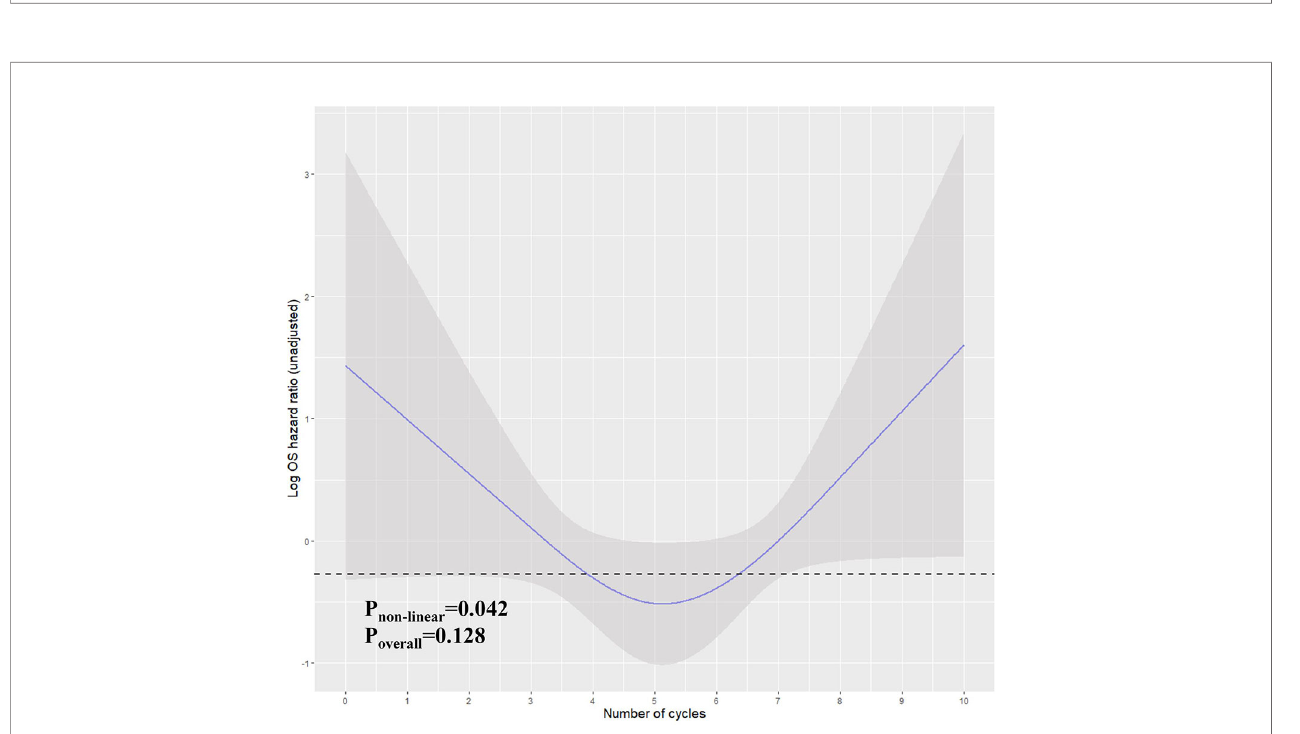
FIGURE 8 | Restricted cubic spline for the unadjusted relationship between duration (cycles) and OS in ypT0-2N0 patients. Y-axis demonstrates the unadjusted log hazard of mortality. The grayed ribbon area re fl ects bounds of the 95% CI. p-values were for non-linear Wald test. The area under the dashed line indicates the relative HR from PEC cycles 4 –